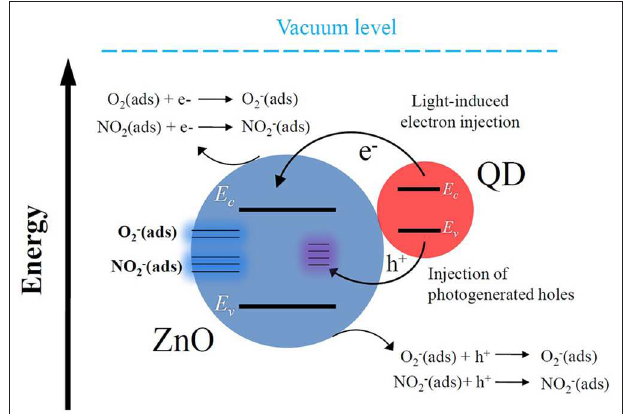
FIGURE 8 | A schematic diagram of the interaction between ZnO matrix, QD and NO 2 and O 2 molecules.